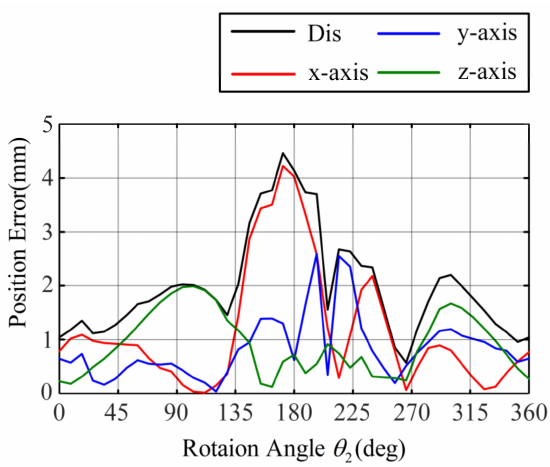
Figure 11. Error of the rotating tip position of the inner tube of the improved model.